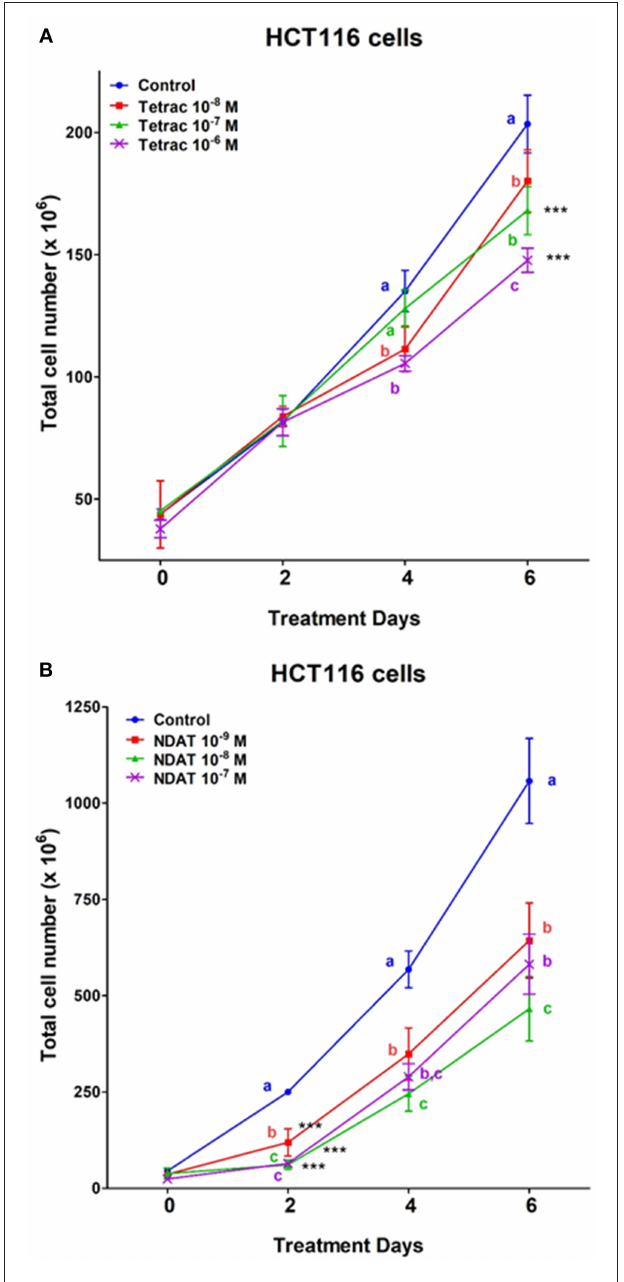
FIGURE 4 | Tetrac (A) and NDAT (B) induce anti-proliferation of K-RAS -mutant colorectal cancer HCT116 cells. HCT116 colorectal cancer cells were grown in the perfusion bellows system and treated with tetrac (10 − 8 to 10 − 6 M) or NDAT (10 − 9 to 10 − 7 M) for 6 days. After incubated in the treatment, cells were isolated and subjected to analysis by cell count. N = 3. Data are expressed as mean ± SD; *** p < 0.001, compared with untreated control. a–c: the subsets after post hoc analysis after the significant differences were obtained using one-way